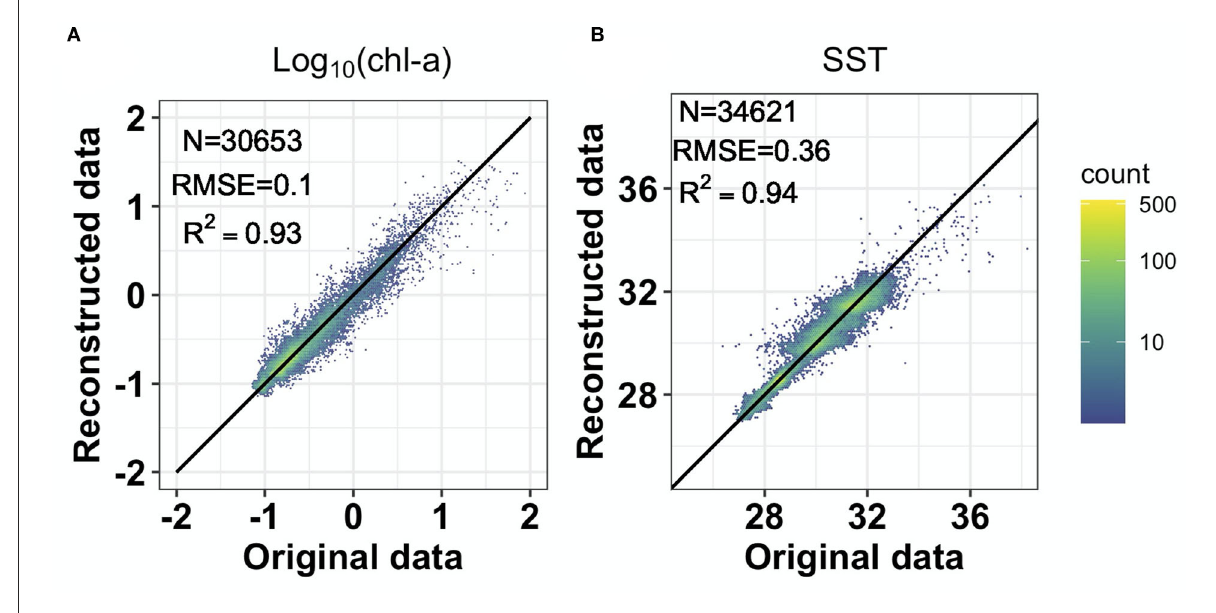
FIGURE2 DINEOF validation between original and reconstructed data of chl-a (A) and SST (B) .